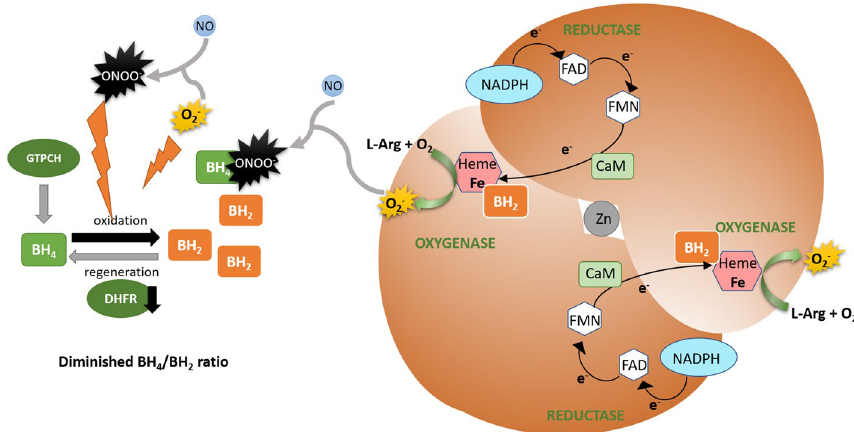
Fig. 2 eNOS uncoupling due to BH 4 deficiency. Under conditions of oxidative stress, O 2 − can combine with NO yielding ONOO − , which strongly oxidizes BH 4 to BH 2 . Decreased DHFR expression or activity prevents effective regeneration of the cofactor. BH 2 competes with BH 4 at the heme oxygenase domain but is not catalitically active, thus disturbing the normal electron flow and promoting superoxide